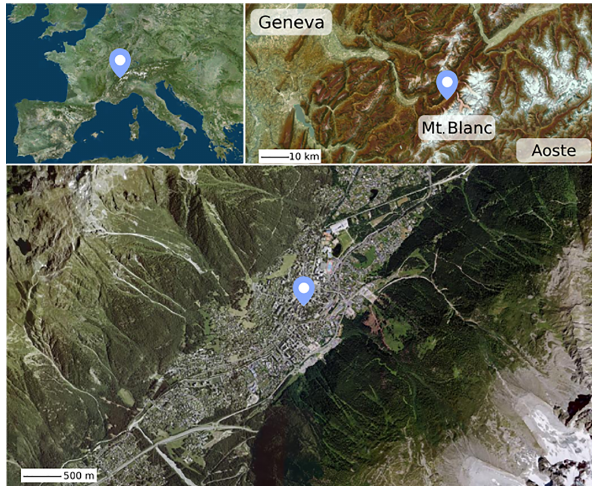
Figure 1. Location of the sampling site in Chamonix, in the Arve valley, France (45 ◦ 55.358 (cid:48) N, 6 ◦ 52.194 (cid:48) E). ©PlaneteObserver,